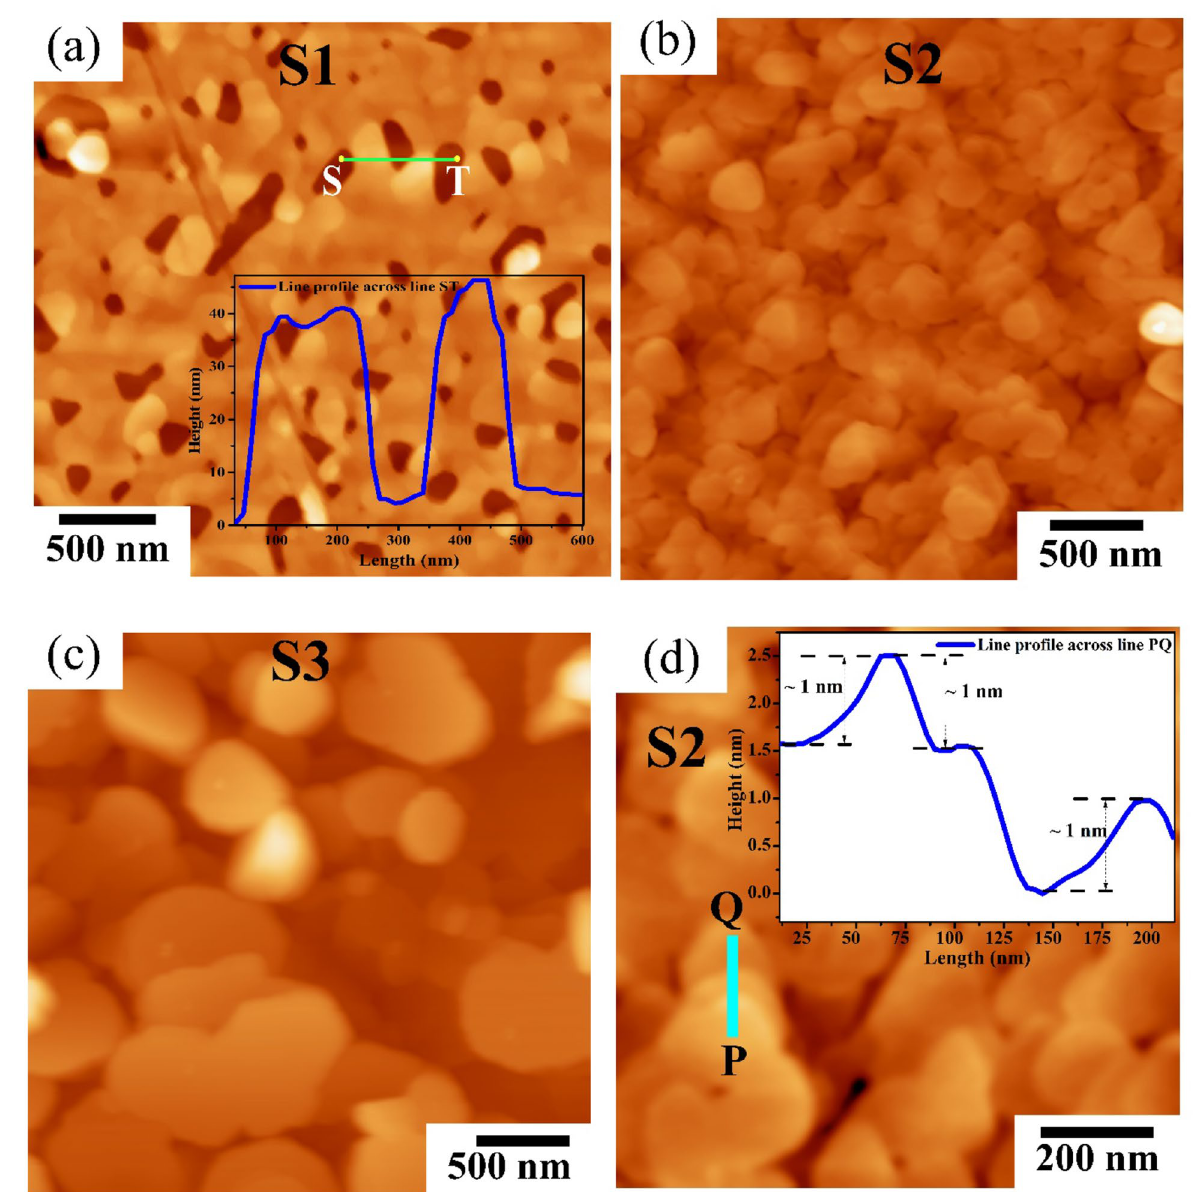
Figure 3. Large scan area (3 μm) 2 topographic tapping mode AFM images for samples S1 ( a ), S2 ( b ) and S3 ( c ). ( d ) AFM image of sample S2 with scan area of (1 μm) 2 and inset shows the line profile across PQ line. Inset of ( a ) shows the line profile along ST